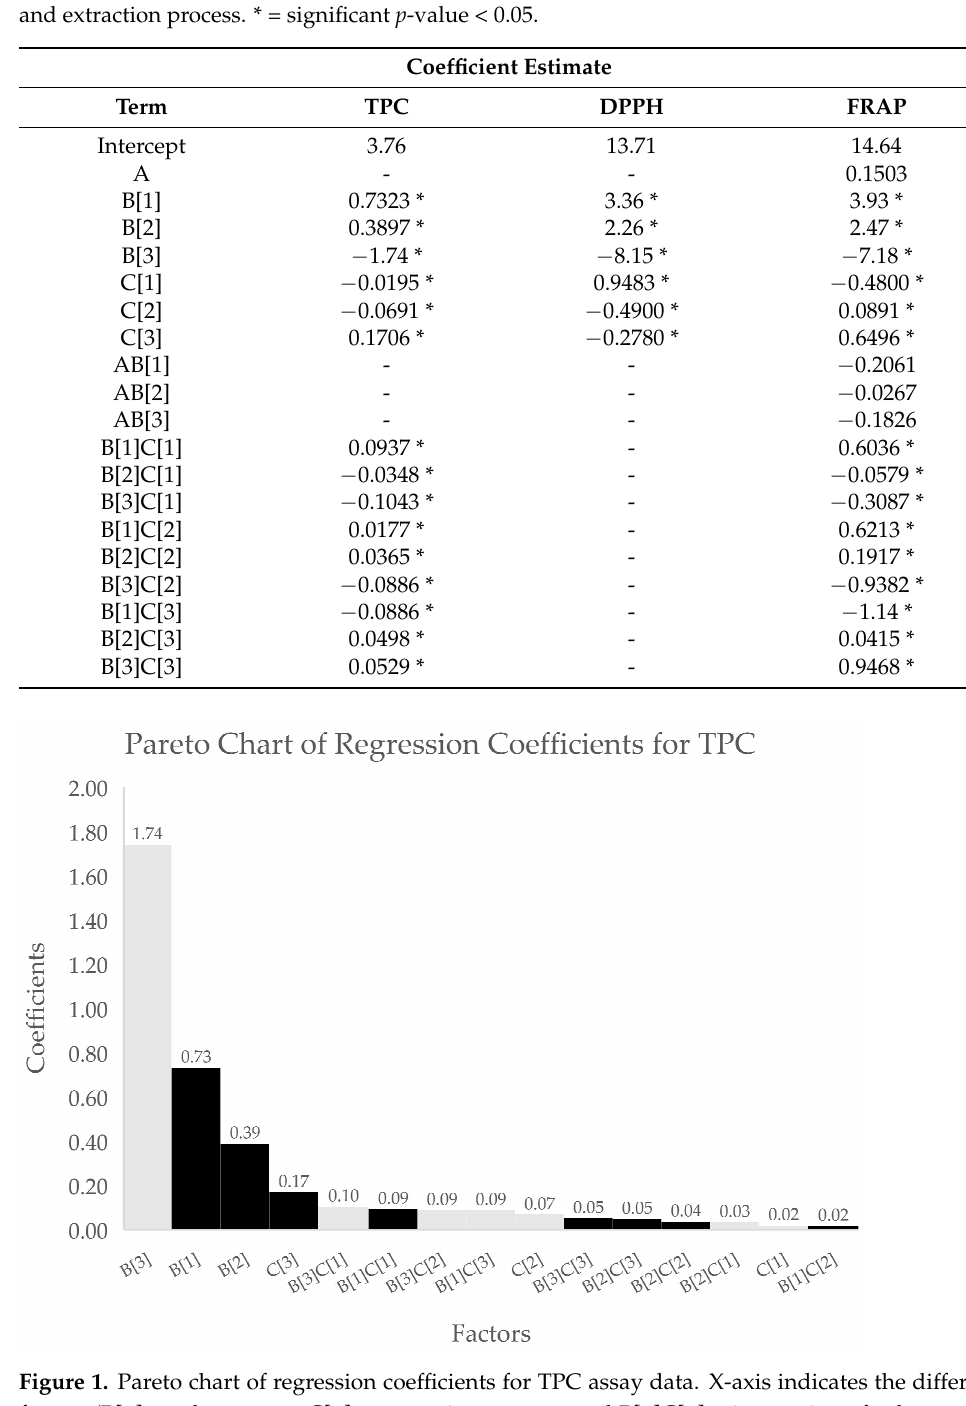
Figure 2. Pareto chart of regression coefficients for DPPH antioxidant activity data. X-axis indi- cates the different factors (B[ n ]=solvent type and C[ n ]=extraction process,) while the values in the left y-axis indicate the coefficient values for the corresponding factors. Black bars indicate positive effect, while white bars indicate negative effect on DPPH antioxidant activity.